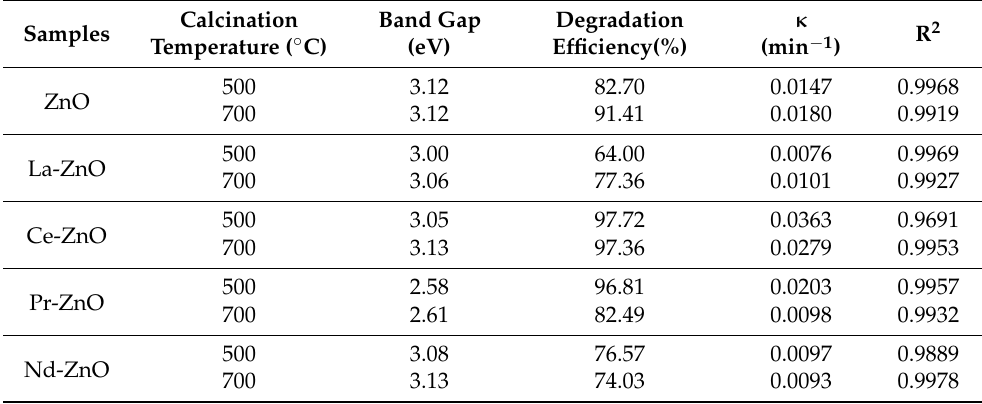
Figure 6. The band gap energies of ZnO and M-ZnO (M = La 3+ , Ce 3+ , Pr 3+ and Nd 3+ ) nanoparticles: ( a ) calcined to 500 ◦ C and ( b ) calcined to 700 ◦ C. Table 4. Degradation efficiency (%) and pseudo-first-order rate constant ( κ ) for the photocatalytic degradation of RhB using ZnO and M-ZnO (M = La 3+ , Ce 3+ , Pr 3+ and Nd 3+ ) nanoparticles calcined to 500 ◦ C and 700 ◦